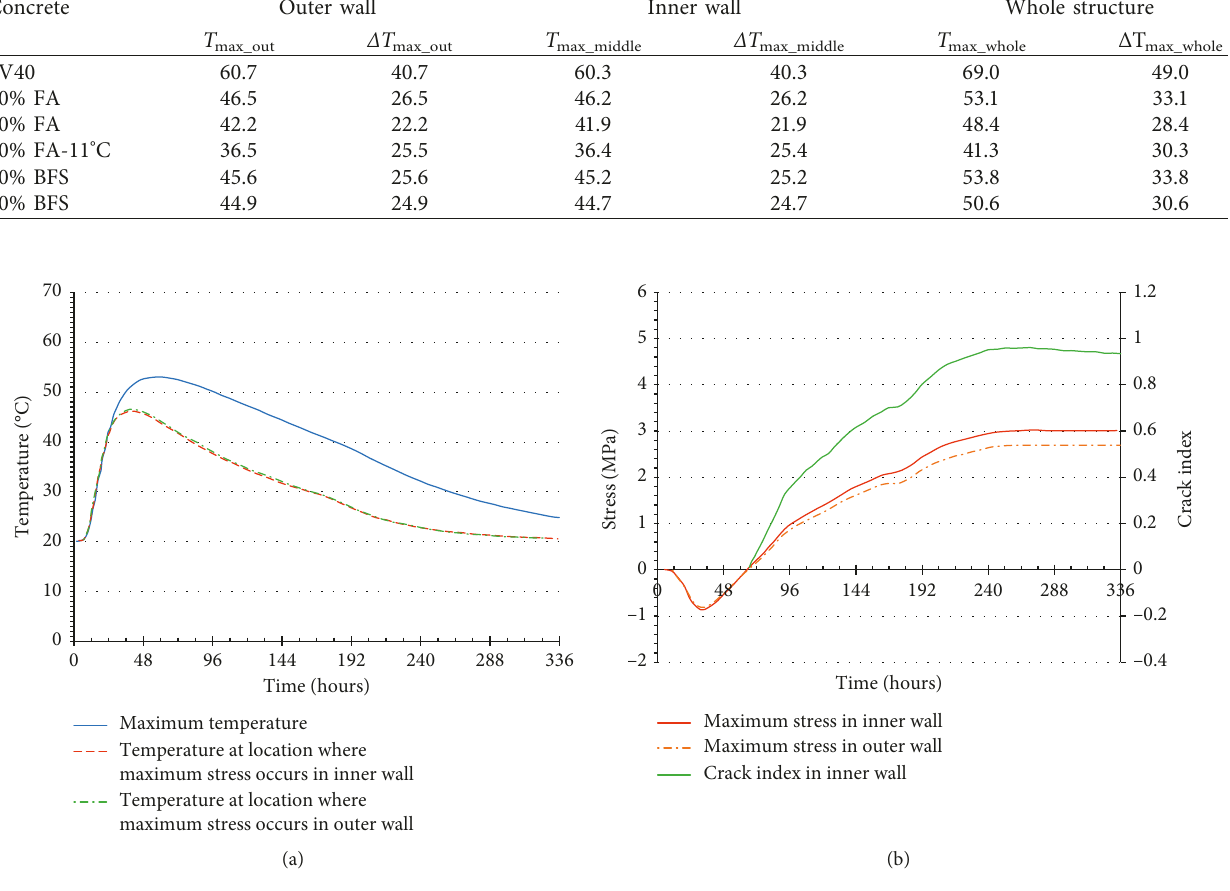
Figure 8: Calculated temperature (a) and stress (b) developments of 40% FA concrete.